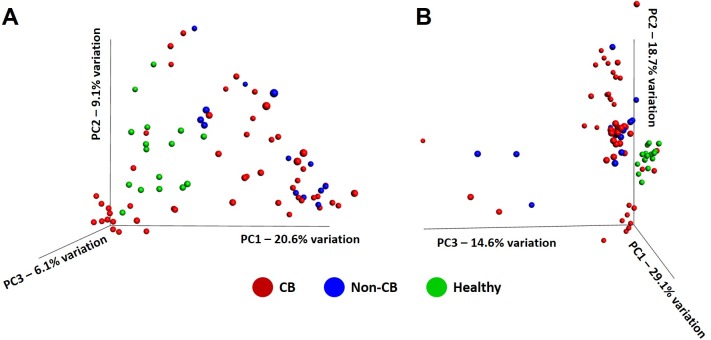
Principal coordinate analysis generated using a uniform number of randomly subsampled reads (1068/sample) and either unweighted (A) or weighted (B) UniFrac distances, showing the similarity of the microbial communities detected in bronchoalveolar lavage fluid from healthy research dogs (n = 16), dogs diagnosed with non-bronchitic chronic respiratory disease (non-CB, n = 13 samples from 11 dogs), and dogs diagnosed with chronic bronchitis (CB, n = 53).